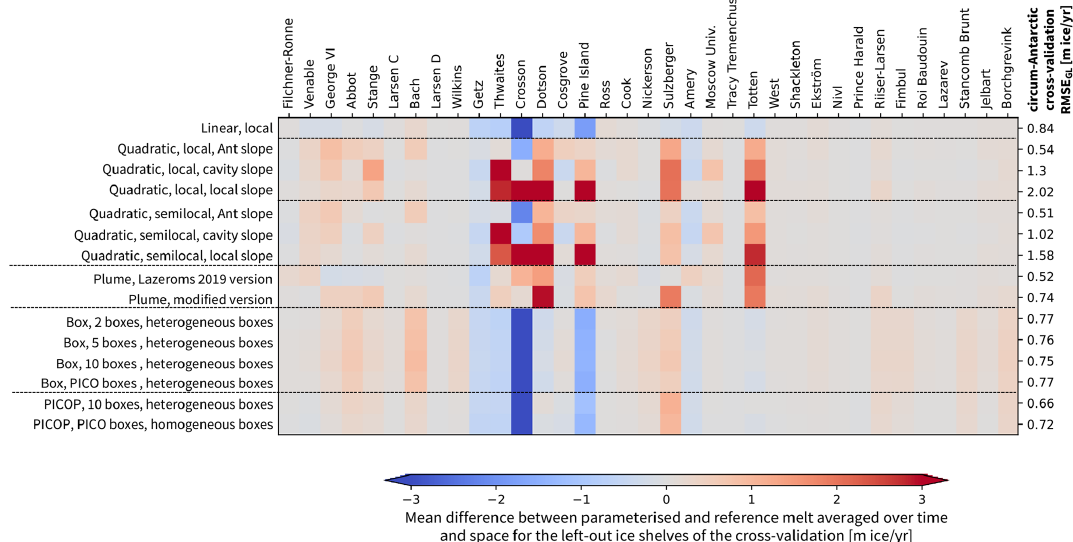
Figure E3. Mean difference between parameterised and reference melt rate averaged over time and space near the grounding line for the synthetically independent evaluation dataset for the cross-validation over ice shelves. The average is taken over the time mean averaged spatially over approximately the 10% of the ice shelf nearest to the grounding line (area covered by the first box in the five-box configuration of the box parameterisation) across the four simulations. The values on the right are the RMSE GL for the cross-validation over ice shelves shown in Fig. 7. “Ant slope” stands for “Antarctic